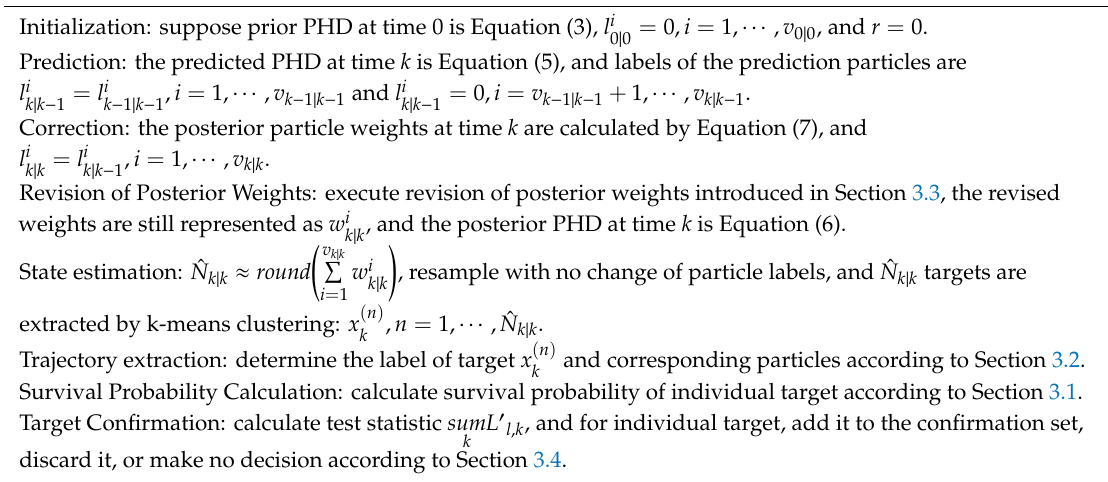
Algorithm 3 Refined PHD